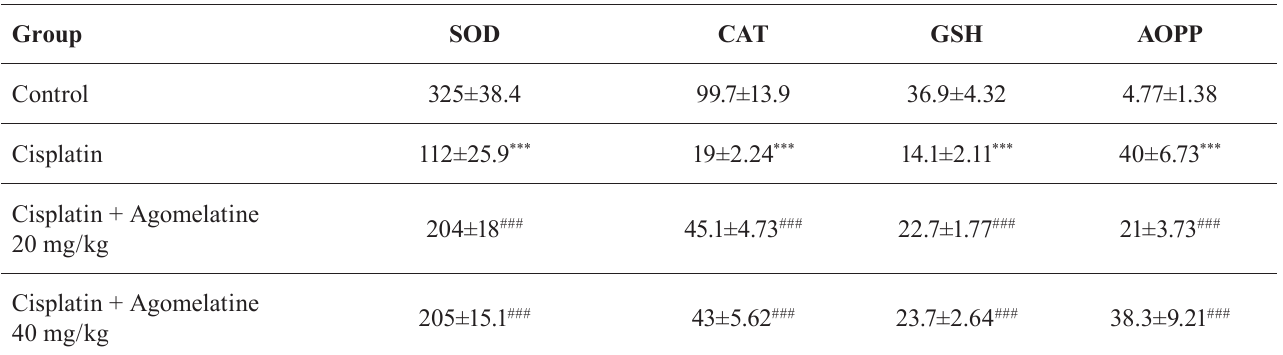
TABLE II - Levels of investigated parameters in kidney tissue for all experimental groups